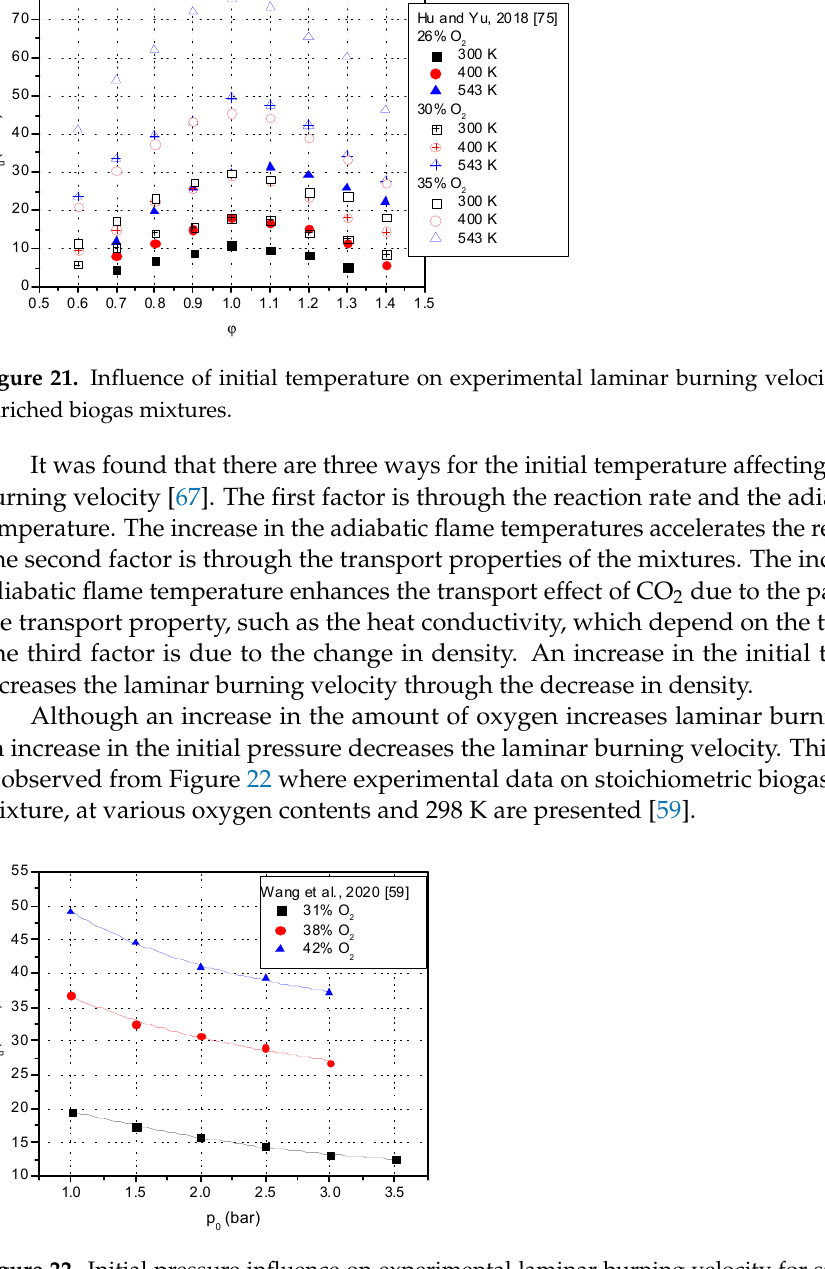
biogas mixtures.